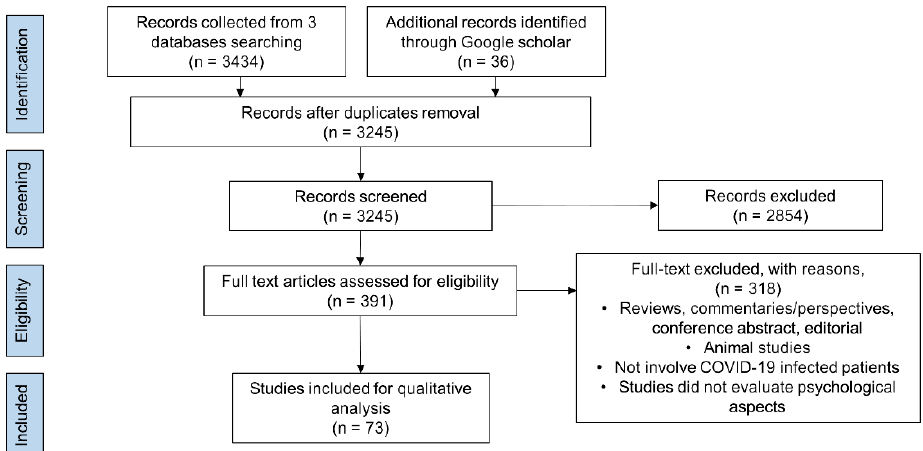
Figure 1. PRISMA flow diagram of the study search and selection process.